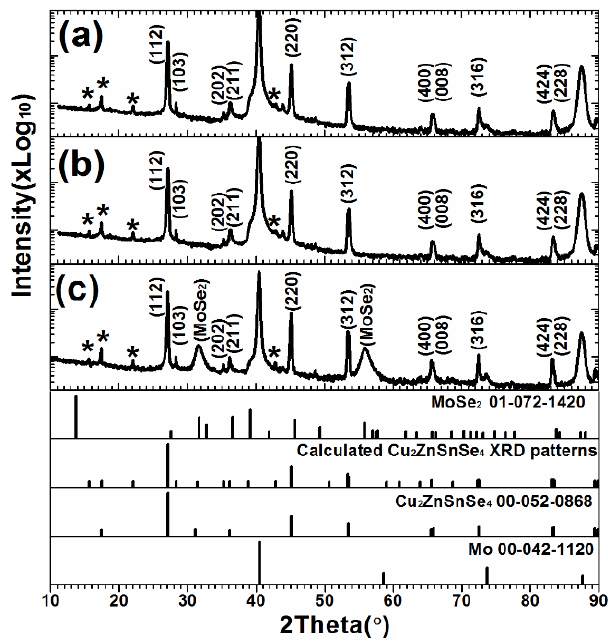
Figure 4. The XRD spectra of the CZTSe thin films that were prepared by the selenization of the precursor with samples ( a ) A1; ( b ) A2; and ( c ) A3.